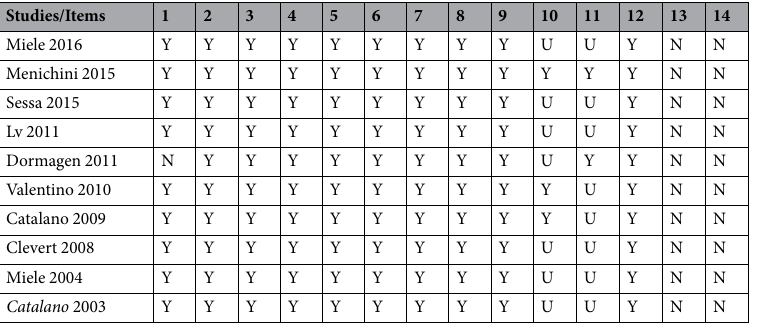
Table 3. Quality assessment of included studies using QUADAS